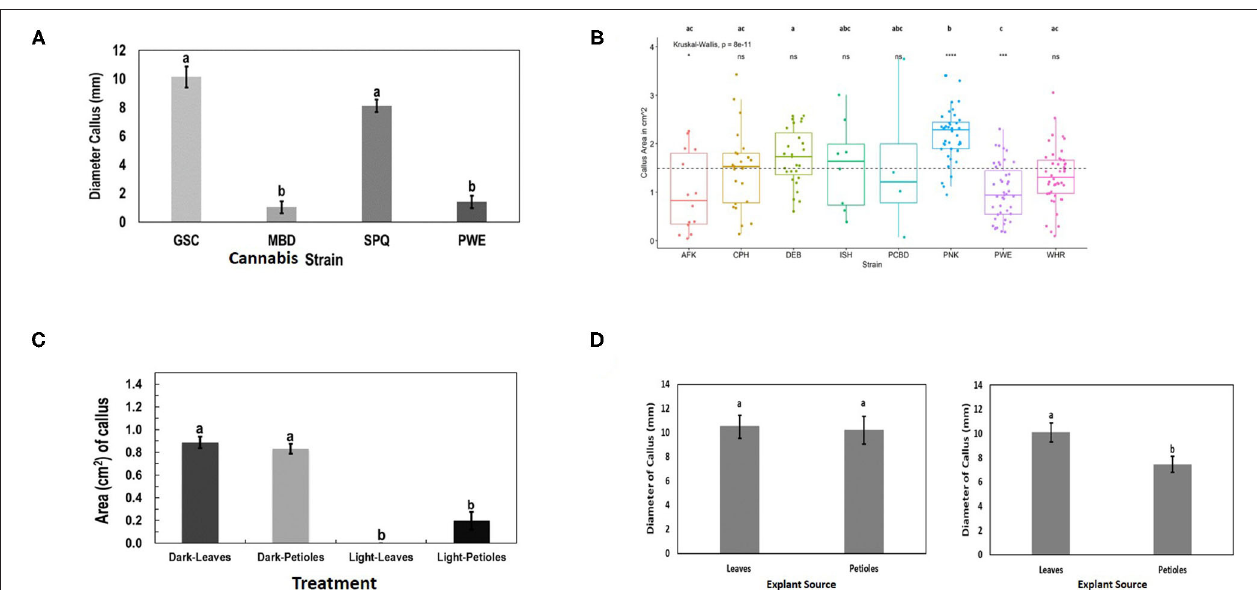
FIGURE 9 | Response of cannabis genotypes to callus development on MM without activated charcoal (MM-AC). (A) Callus diameter of four genotypes developing from 1 cm 2 leaf explants. (B) Callus area from leaf explants of 8 cannabis genotypes compared with the mean callus area across all strains (represented by the dotted line). The “*”represents significance level and “ns” represents not significant relationships between each genotype and across all genotype means (dotted line). A Kruskal–Wallis test resulting in a p of 8 × 10 − 11 and a Games–Howell post-hoc test were performed. Significant differences identified in the Games–Howell post-hoc test are shown using letters above the boxplots of each strain. (C) Growth of Cheesequake (CHQ) callus from leaf and petiole explants after 1 month under 24-h dark and 24-h light conditions on MM. Statistical analysis was performed by Tukey’s HSD test with significance at p < 0.05. Bars followed by different letters indicate significant differences. (D) Growth of callus from leaves and petioles of genotype Girl Scout Cookie (GSC) (left) and Space Queen (SPQ) (right). Measurements of diameter were made after 4 weeks. Statistical analysis was performed by Tukey’s HSD test with significance at p < 0.05. Bars followed by different letters indicate significant